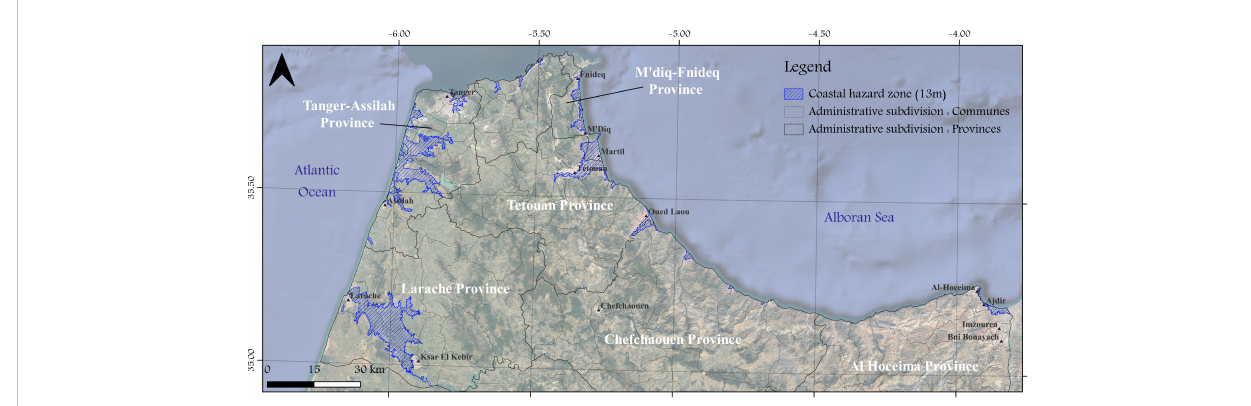
FIGURE 3 Coastal hazard zone (13m asl) for the TTA region. Background satellite imagery corresponds to google satellite of 2023, available as Basemap in QGIS v3.22.11